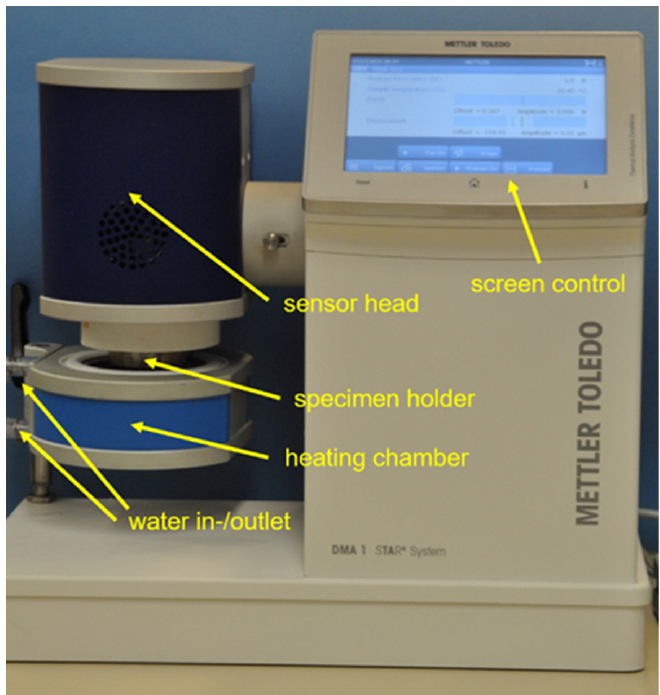
Figure 3. Dynamic mechanical analyzer (DMA 1) with heating chamber and specimen holder.